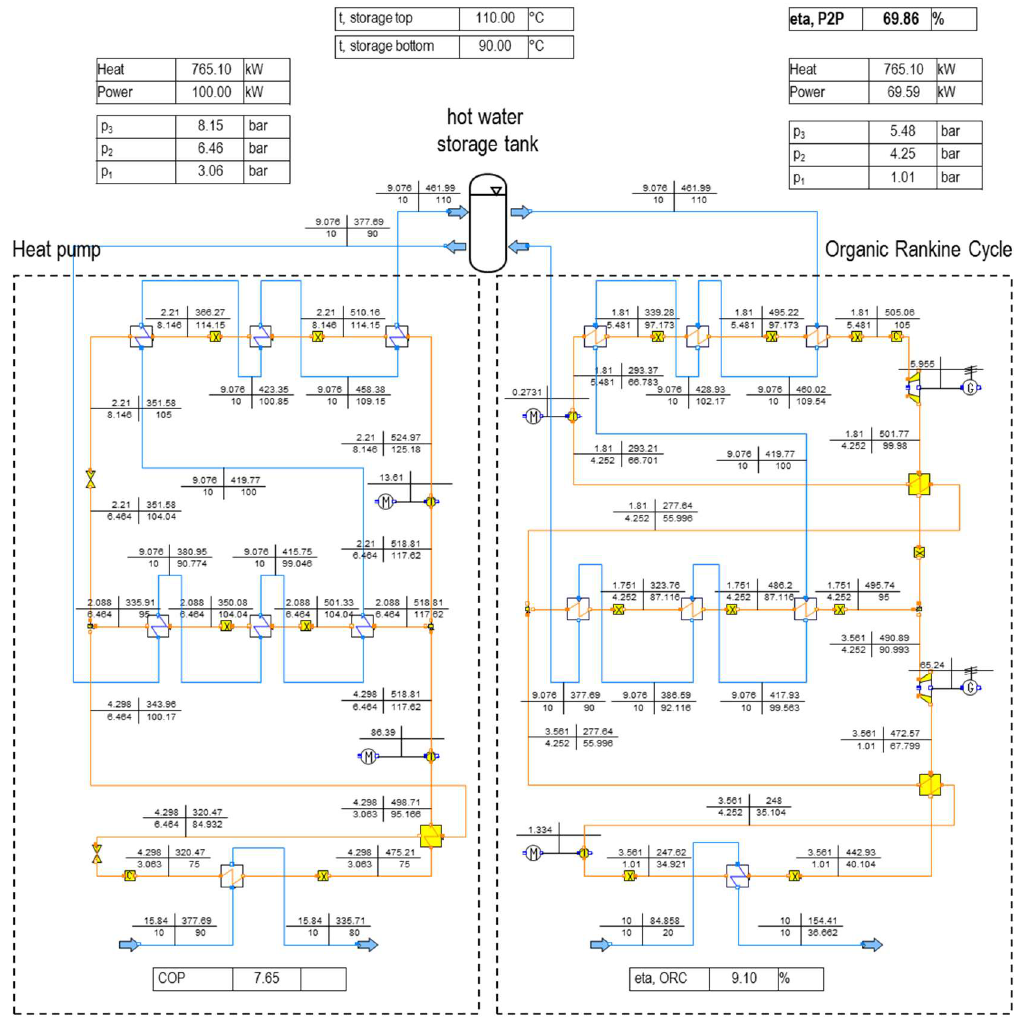
Figure 9. IPSEpro simulation of a process design with staged condensation and evaporation and additional recuperation with optimized temperature spread of the water storage (isentropic efficiencies of compressors and expanders 70%, waste heat temperature 90 ◦ C, ambient/ORCs condenser temperature 40 ◦ C, terminal temperatures at the pinch points 5 K). Fixed and independent variables for the simulation of the HP- Organic Rankine Cycle